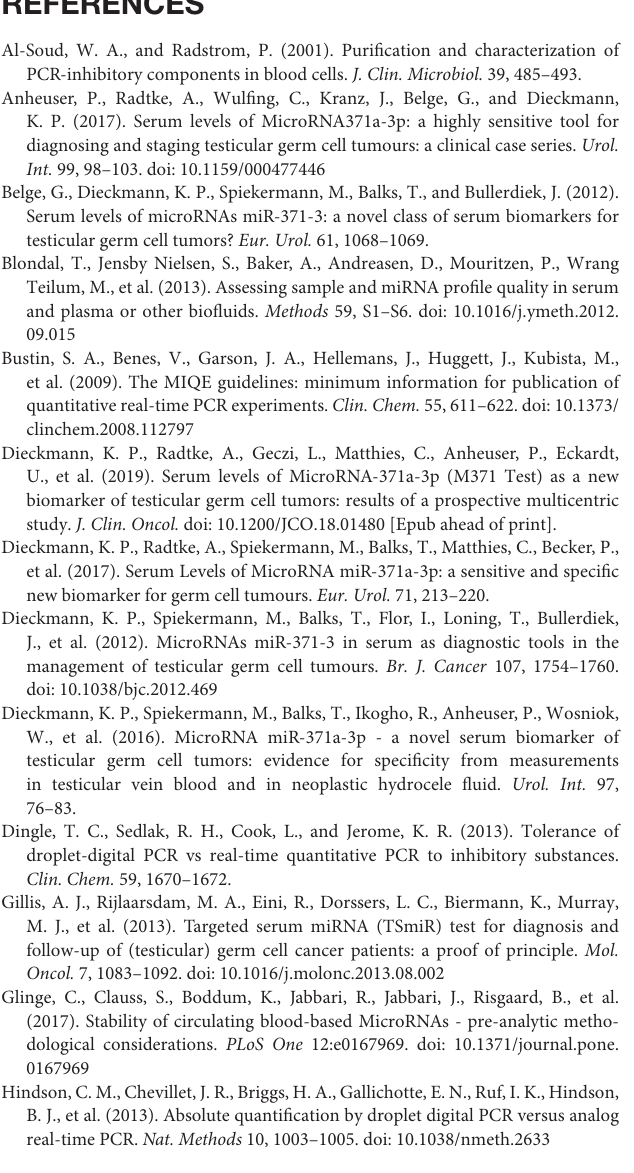
FIGURE S1 | Cq-values for UniSp4, cel-miR-39-3p, miR-93-5p, miR-30b-5p, miR-371a-3p and miR-372-3p in two patient samples spiked with hemolyzed